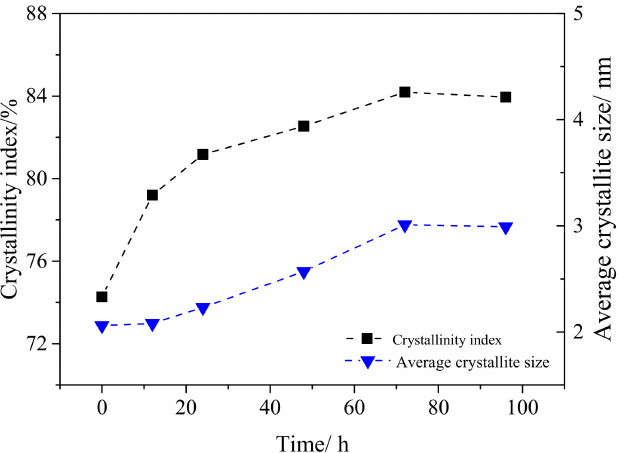
Figure 9. The variations of CrI and average crystallite size ( I hkl ) of α -cellulose during the enzymatic